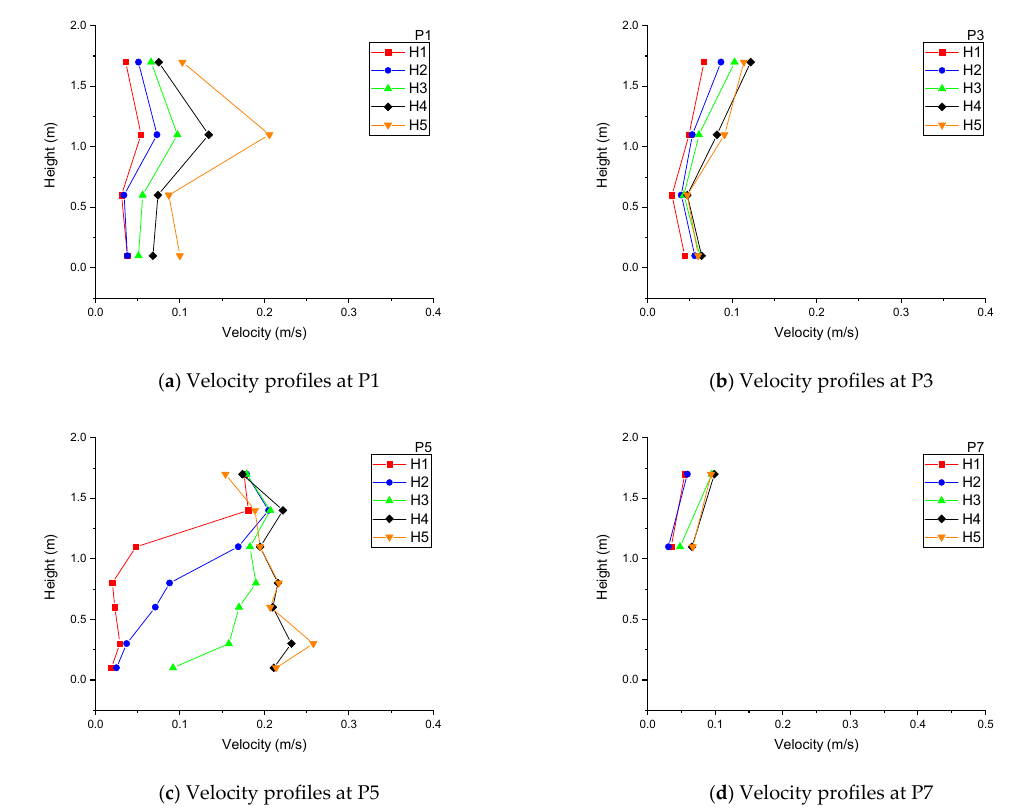
Figure 7. Velocity profiles at position P1 ( a ), P3 ( b ), P5 ( c ) and P7 ( d ) for heating cases (H1–H5).